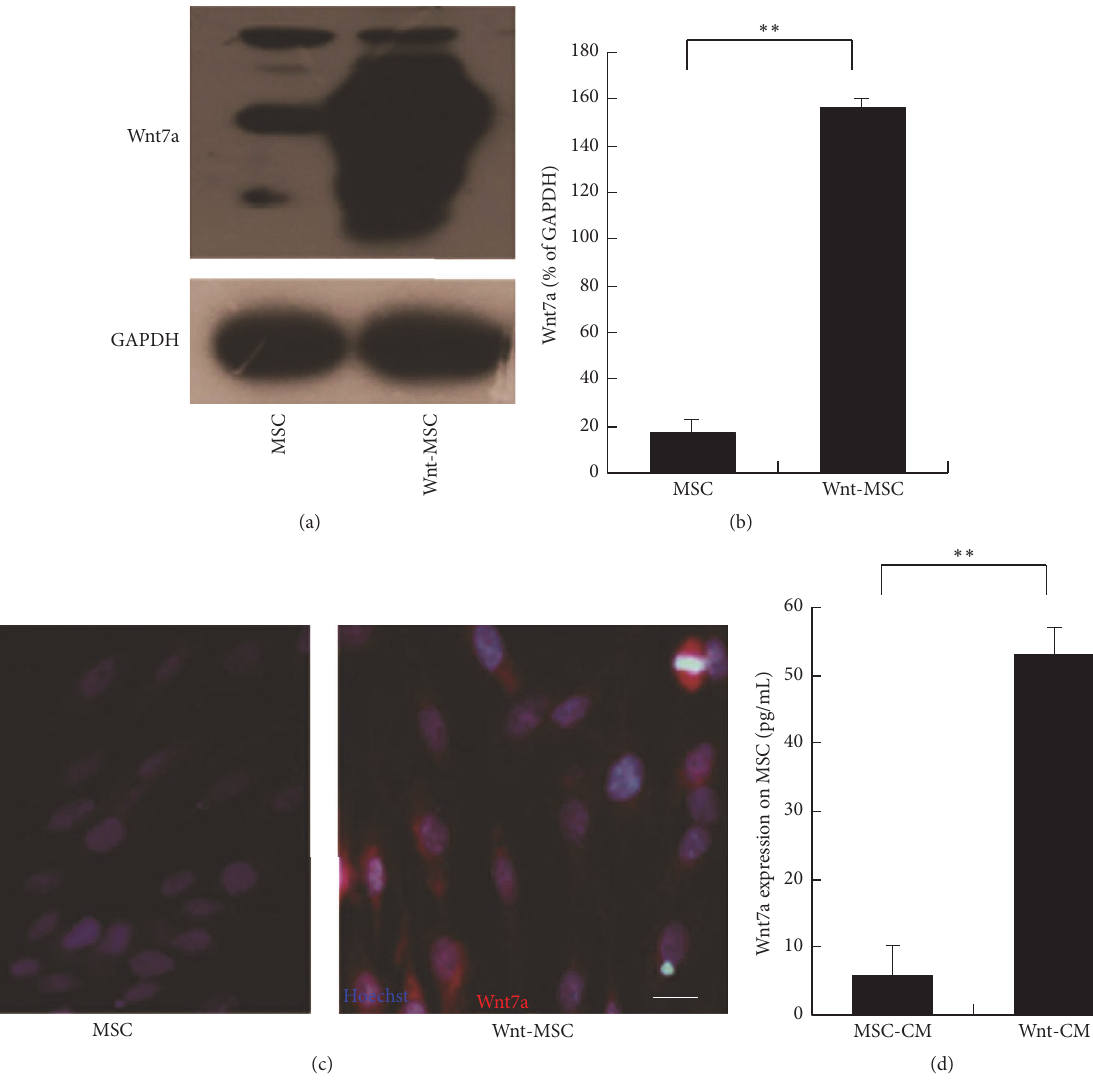
Figure 1: Wnt7a expression in human MSCs. (a, b) Western blots of Wnt7a and corresponding semiquantitative analysis. (c) Immunocy- tochemical analysis of MSCs overexpressing Wnt7a. The nuclei were counterstained with Hoechst. (d) Wnt7a was quantified in the CM by ELISA. The data are presented as mean ± SEM, 𝑛 = 3 ; ∗∗ 𝑃 < 0.01 . In the images, Wnt7a (red fluorescence) and Hoechst (blue fluorescence) staining are shown. The scale bar in panel (b) is 20 𝜇